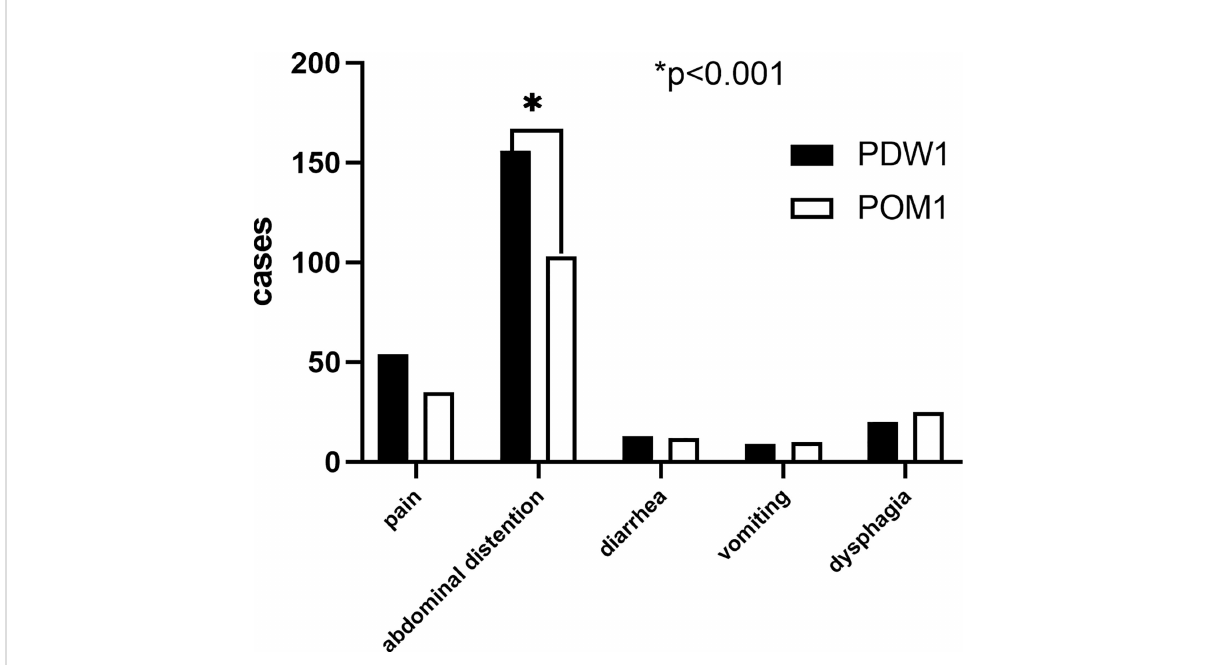
FIGURE 1 Frequency of postoperative gastrointestinal symptoms in the 356 patients. * p <